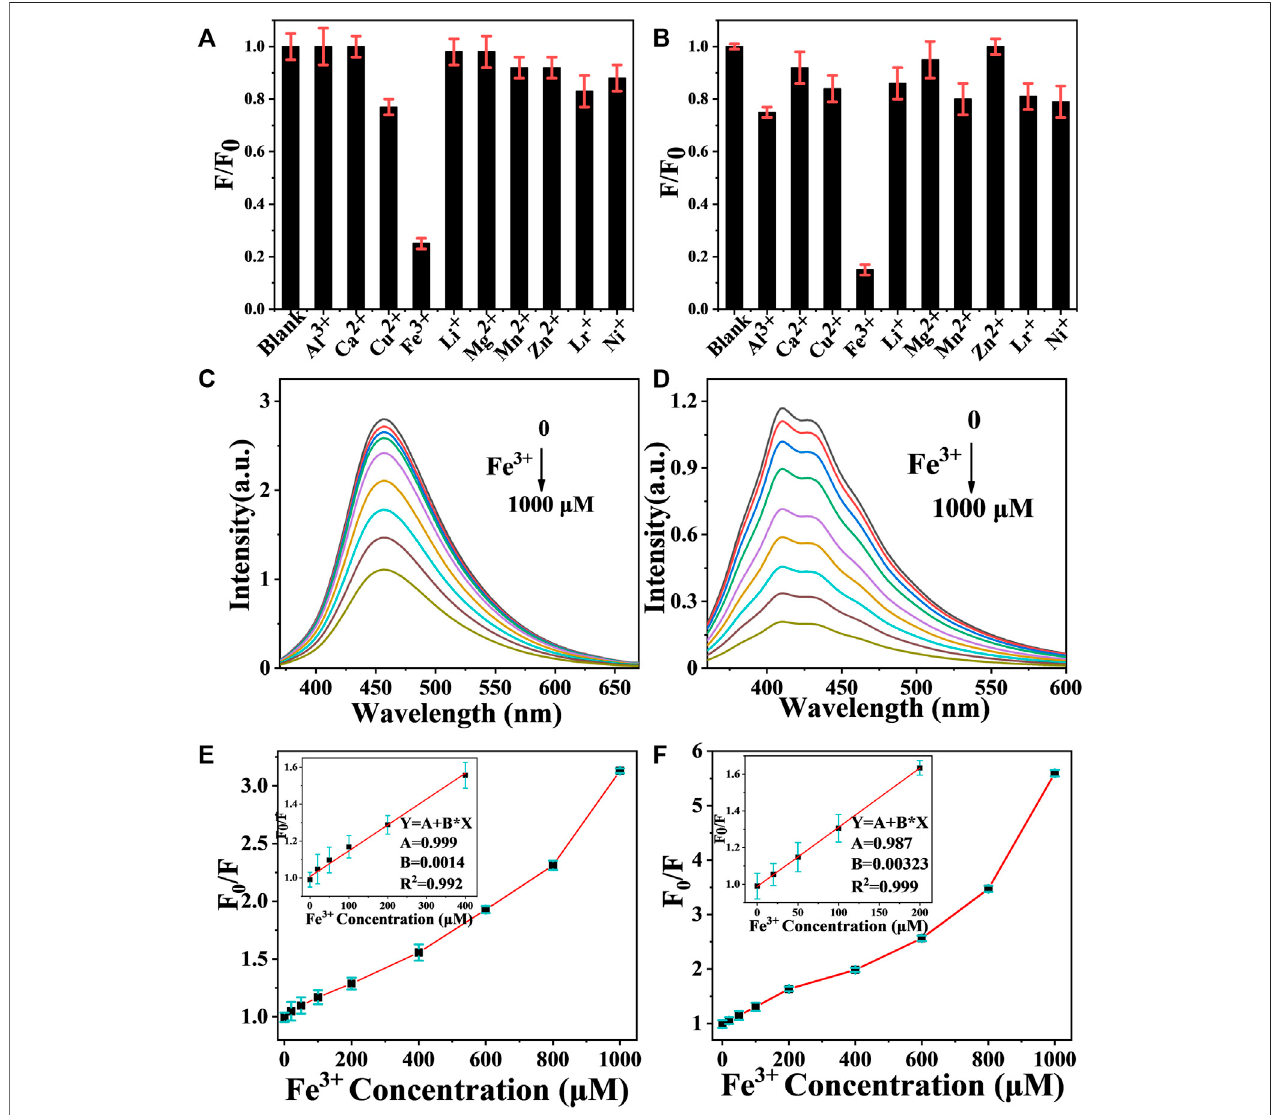
FIGURE 7| (A,B) Fluorescent responses of1000 μ M CDs-C 300 and CDs-L 350 todifferent metal ions, F 0 and F present the fl uorescence intensity ofCDs before andafteraddingmetalions. (C,D) FluorescenceemissionspectraofCDs-C300andCDs-L350aftertheadditionofdifferentFe 3+ concentrations. (E,F) PlotsoftheF 0 /F with different Fe 3+